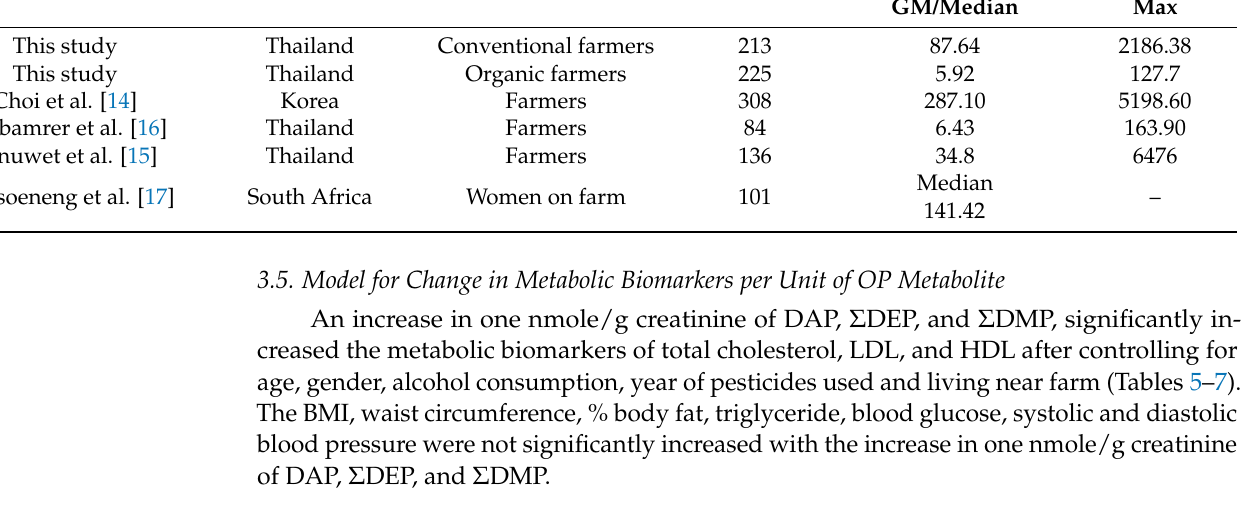
Table 5. Individual generalized linear model models for change in each metabolic biomarker per one unit of Ln Σ DMP. Adjusted models include covariates for age, gender, alcohol consumption, years of pesticide use, living within 1 km of a farm.